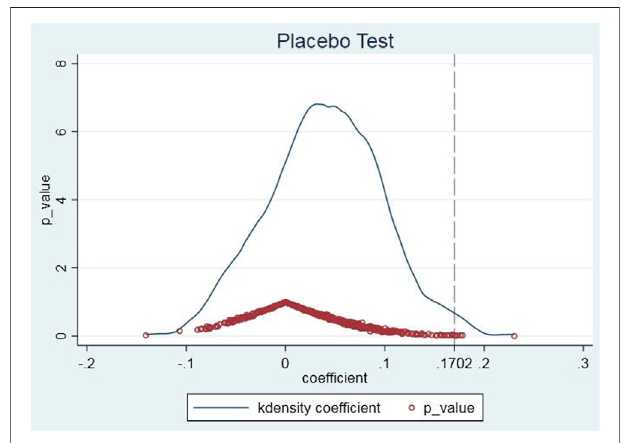
FIGURE 3 | Results of the placebo